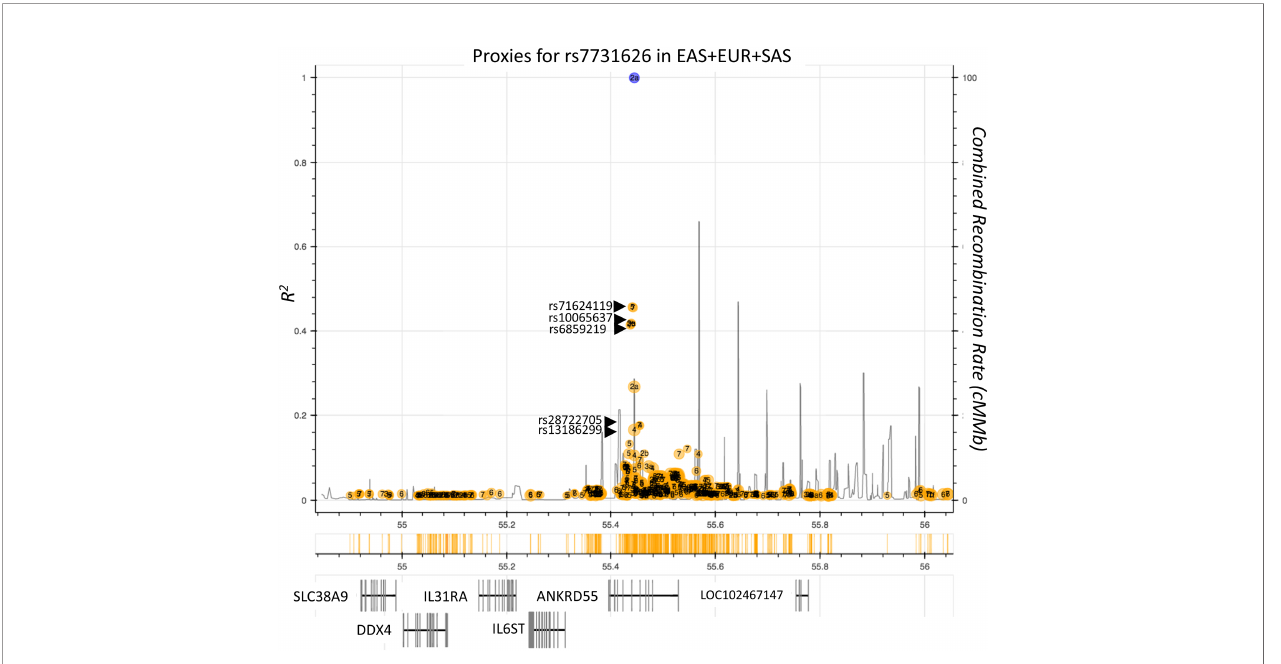
FIGURE 1 | Autoimmune risk SNPs located in the ANKRD55 gene area. Plot represents individual LD r 2 values of SNPs (ocher circles) located in the delineated genomic interval with the main autoimmune risk SNP rs7731626 (blue circle). SNPs independently associated with autoimmune diseases with genome-wide signi fi cance are indicated (rs71624119, rs10065637, rs6859219). Genes located in this interval are represented in the lower part of the fi gure. Combined recombination rate is provided (black lines). SNPs rs28722705 and rs13186299 have been associated robustly in GWAS with monocyte count (5, 6) and monocyte percentage of white cells (7), respectively. Image information was produced by means of